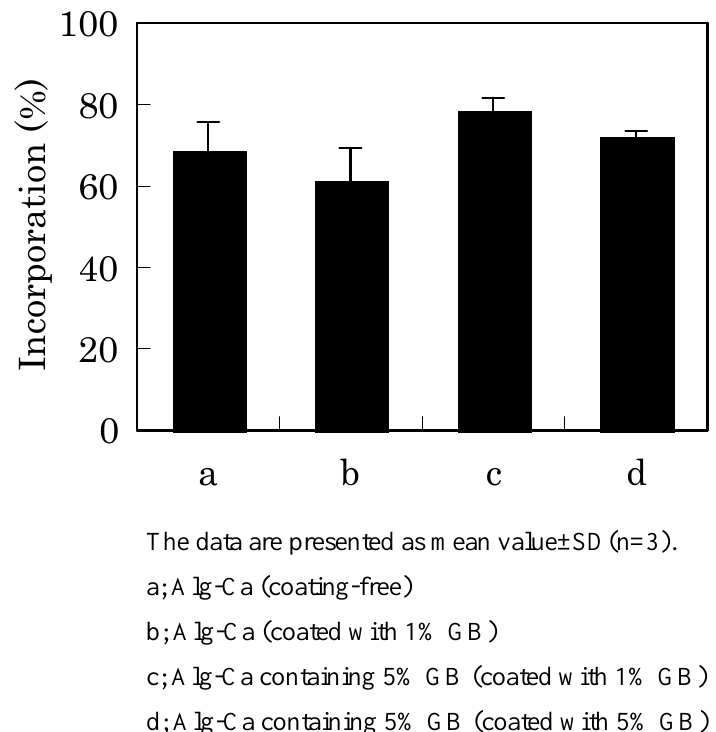
Figure 3. Incorporation of HC in